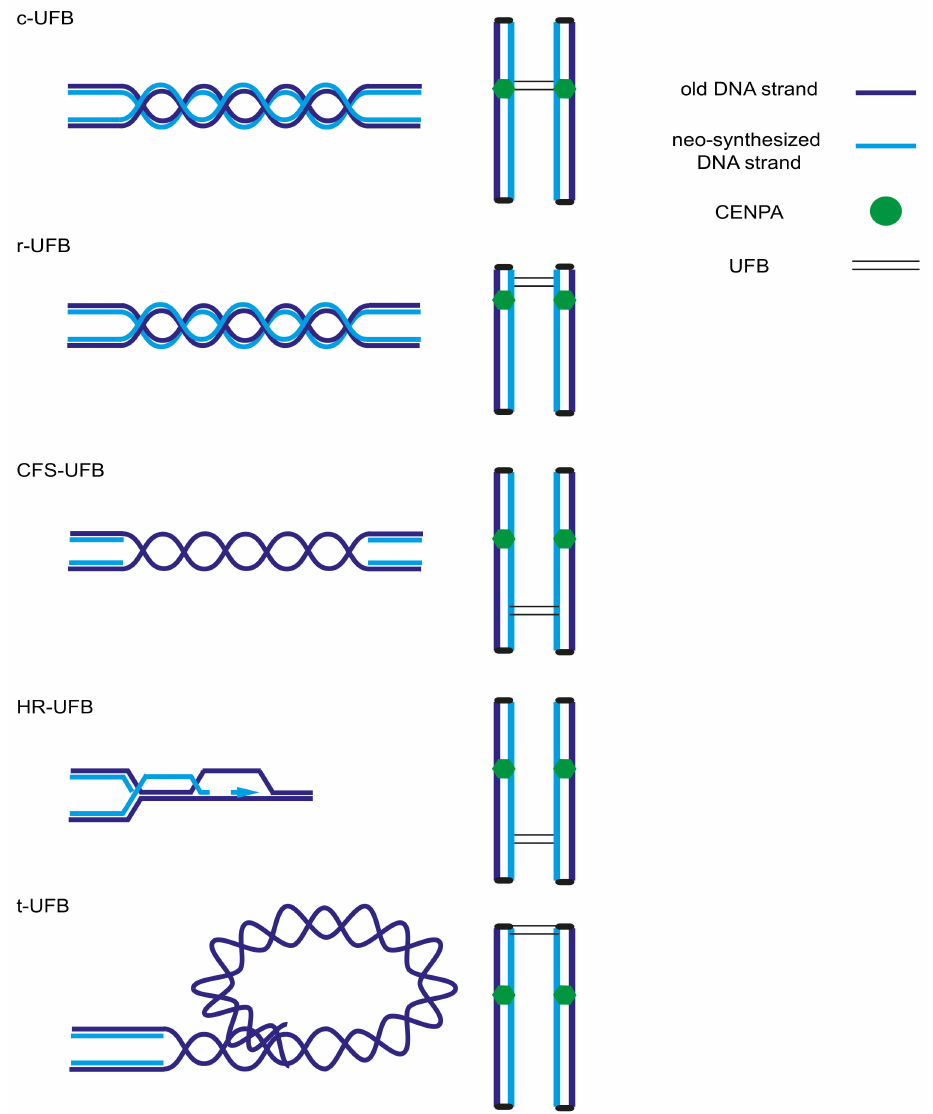
Figure 1. The di ff erent types of ultrafine bridges